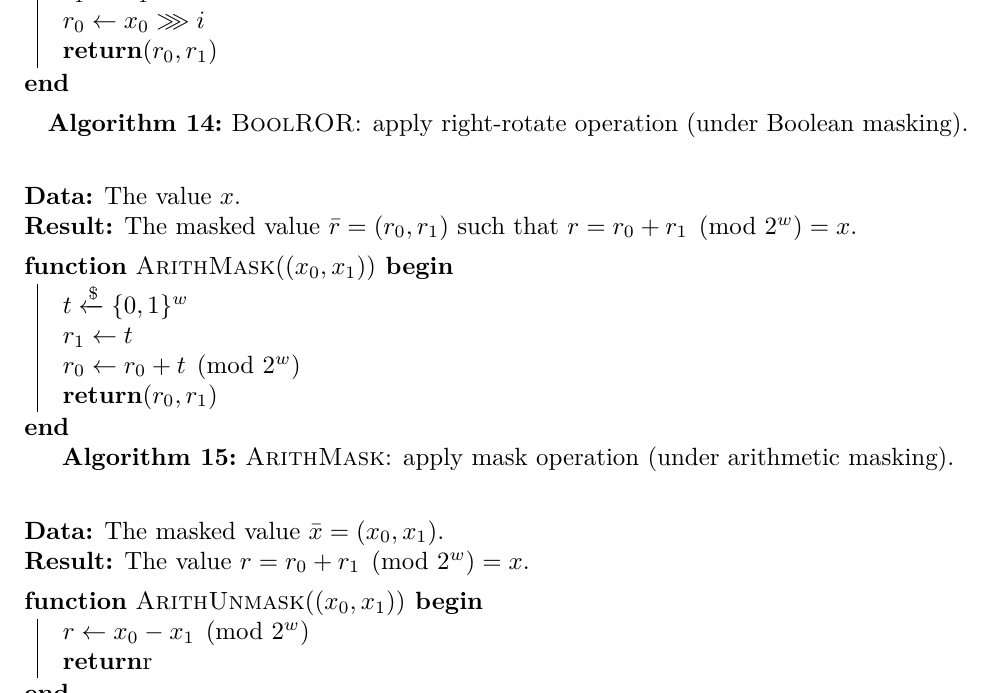
Algorithm 16: ArithUnmask : apply unmask operation (under arithmetic